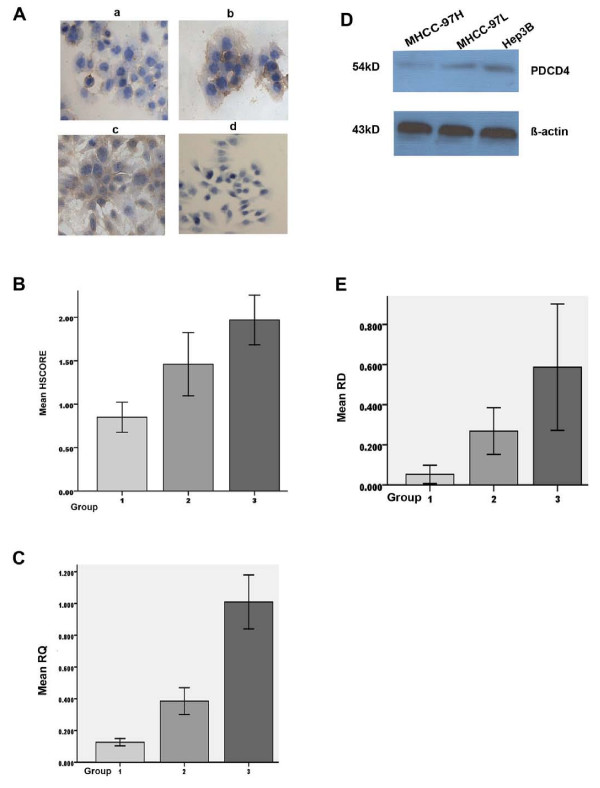
Expression of PDCD4 in HCC cells. A: Immunocytochemical staining. The positive staining(×200) was brownish and localized in cytoplasm. D: Western blot assay. Representative figures are shown from one of three individual experiments. B, C or E shows statistical analysis for immunocytochemical staining, real – time PCR or western blot assay, respectively. In A, a, b or c represents cells of MHCC-97H, MHCC-97L or Hep3B, respectively; d shows cell staining without the primary antibody. In B, C and E, Group1, Group 2 or Group3 represents cells of MHCC-97H, MHCC-97L and Hep3B, respectively. Bars represent the means ± SD. The difference between Group1 and Group2 (P < 0.05) or Group1 and Group3 (P < 0.01 in B; P < 0.05 in E) was significant.